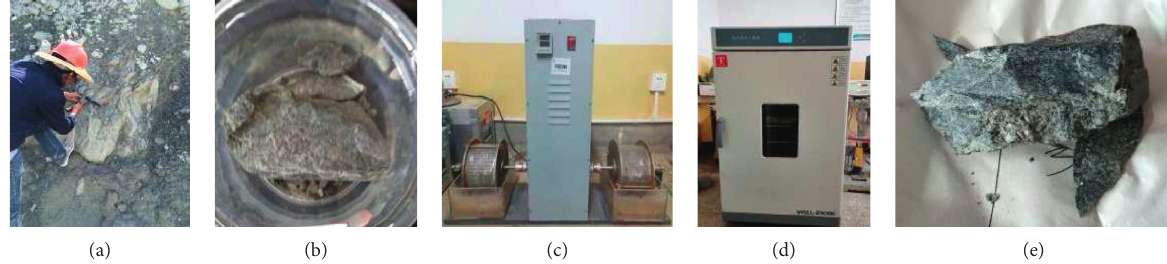
Figure 3: Sample location diagram.